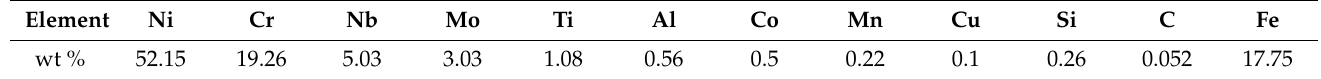
Table 3. Chemical composition of